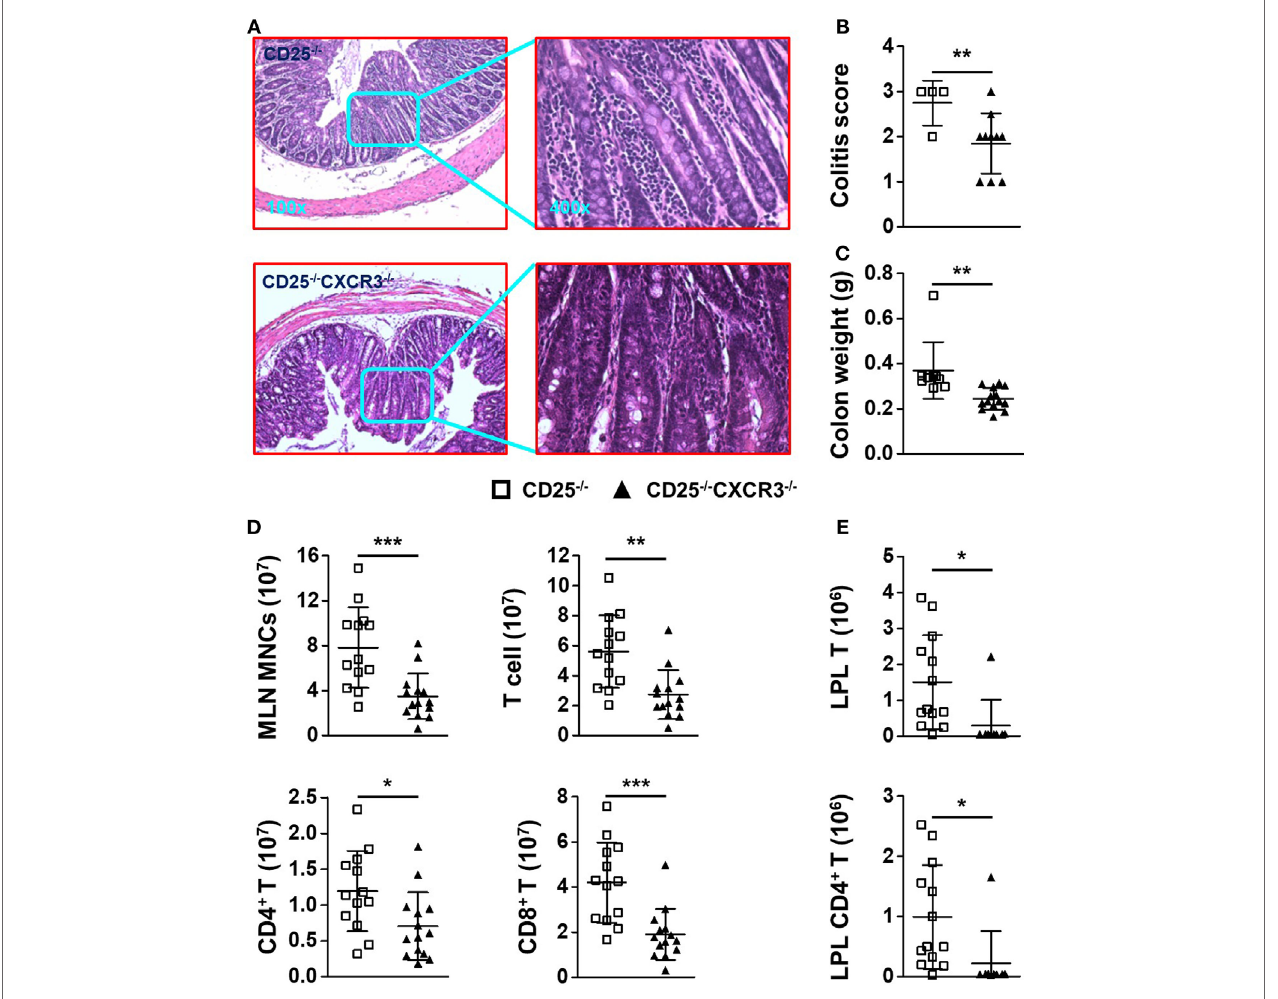
FigUre 4 | CXC chemokine receptor 3 (CXCR3) deletion alleviates colitis of CD25 − / − mice. (a) Representative H&E-stained colon sections of CD25 − / − and CD25 − / − CXCR3 − / − mice at the original magnification of 100 × and 400 × . (B) Scores of colitis in CD25 − / − mice ( N = 4) and CD25 − / − CXCR3 − / − mice ( N = 10). (c) Colon weight of CD25 − / − mice ( N = 7) and CD25 − / − CXCR3 − / − mice ( N = 10). (D) Numbers of mononuclear cell (MNC), T, CD4 + T, and CD8 + T cells in mesenteric lymph nodes (MLN) from CD25 − / − mice ( N = 13) and CD25 − / − CXCR3 − / − mice ( N = 14). (e) Numbers of T and CD4 + T cells in colon lamina propria lymphocytes (LPL) from CD25 − / − mice ( N = 13) and CD25 − / − CXCR3 − / − mice ( N = 9). * p < 0.05; ** p < 0.01; *** p <